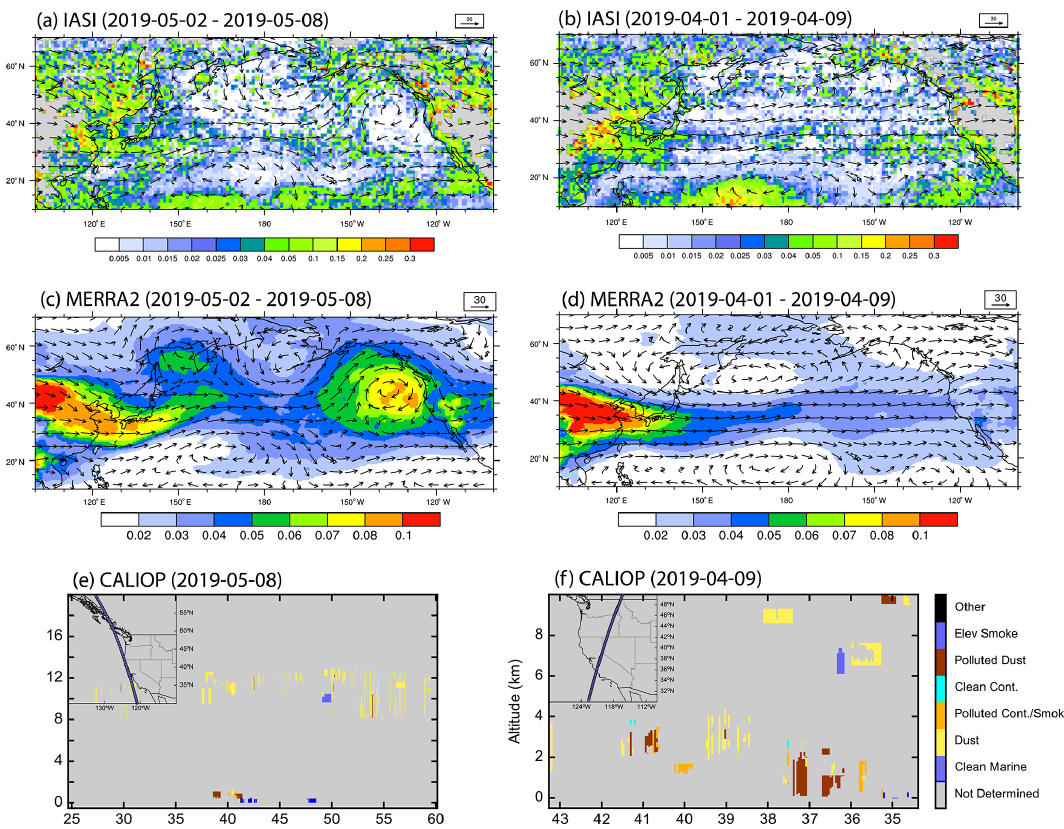
Figure 8. (a) IR DOD from IASI and 500hPa winds (ms − 1 ) from ERA5 over the North Pacific for a typical type 3 case averaged between 2 May 2019 and 8 May 2019. (b) Same as (a) but for a typical type 4 event averaged between 1 April 2019 to 9 May 2019. (c) DOD from MERRA-2 and 500hPa winds (ms − 1 ) from ERA5 for a type 3 event. (d) Same as (c) but for a type 4 event. (e) Latitude–height cross-section of aerosol species from CALIOP on 8 May 2019 (type 3). (f) Same as (e) but for a typical type 4 case on 9 April